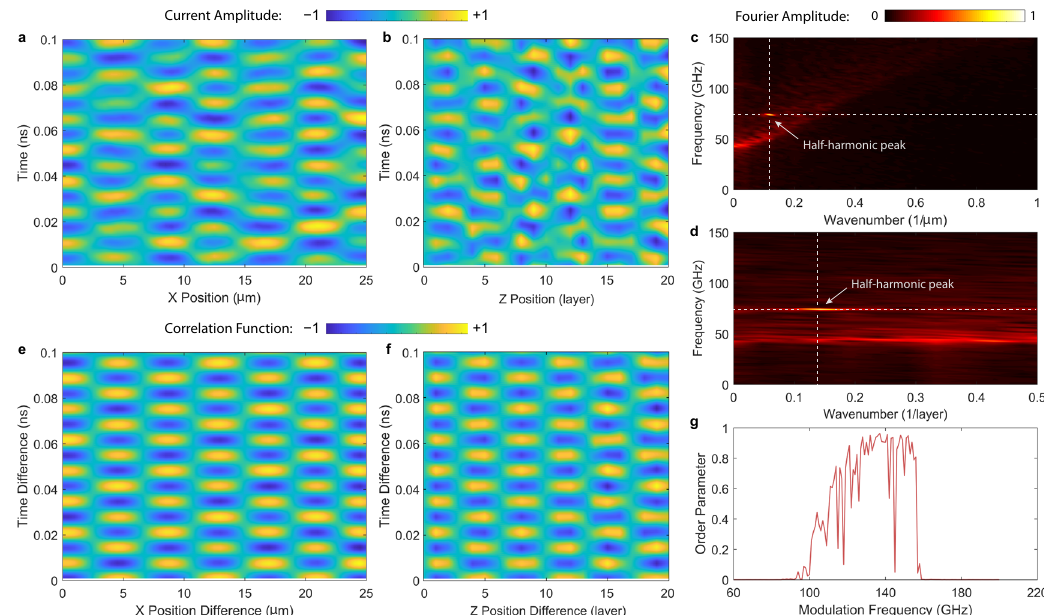
Fig. 4 Calculation on an effectively 2D multi-layer long Josephson junction stack in BSCCO at 4 K under parametric modulation. The junction length is L = 25 μ m, width is W = 2 μ m, and layer number is N = 20. a Space − time trace of j z ( x , 0, t ) in the xt plane when z = 0 in the Floquet steady state under the modulation frequency f mod ¼ 148 GHz and modulation amplitude A mod ¼ 0 : 1. b Space − time trace of j z (0, z , t ) in the xt plane when x = 0. c Fourier transform to j z ( x , 0, t ) plotted in the magnitude ∣ j z ( β , 0, f ) ∣ , where β is the wavenumber along x . d Fourier transform to j z (0, z , t ) plotted in the magnitude ∣ j γ , f ) ∣ , where γ is the wavenumber along z . e Space − time-averaged correlation function g ( δ x , δ z , δ t ) in the δ z = 0 plane. f Space − time-averaged z (0, correlation function in the δ x = 0 plane. The corresponding mode indices are l = 6 and q = 6. g Spatiotemporal order parameter Δ xzt versus the modulation frequency f mod when A mod ¼ 0 : 1 (with fi xed f p , temperature T = 4K, and thermal noise). It shows a more continuously fi lled parametric excitation band (compared with the 1D case) spanning 100 − 160 GHz for A mod ¼ 0 : 1. For A mod ¼ 0 : 1 the correction factor C =